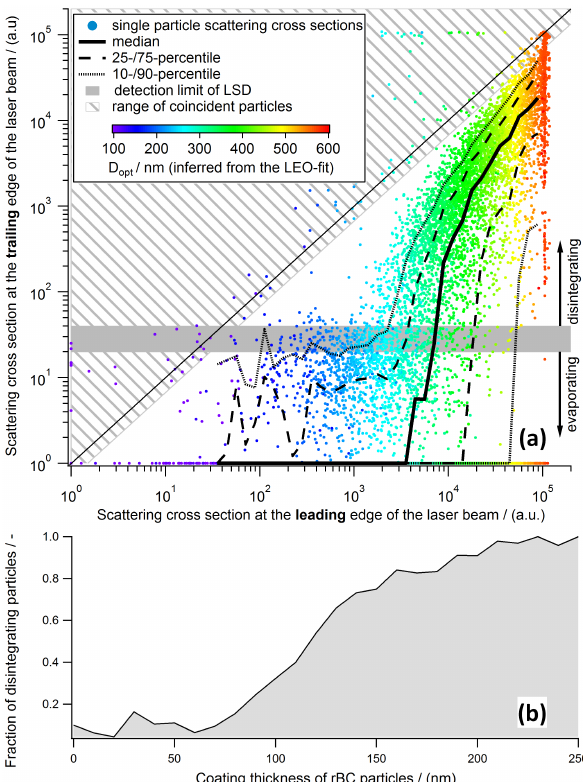
Figure 13. (a) Relation of the scattering cross-section at the leading edge and at the trailing edge of the laser beam for BC-containing particles (dots; color-coded for D opt determined by the LEO-fit approach) with median (solid black line), 25th/75th percentiles (dashed black lines) and 10th/90th percentiles (dotted black lines) shown for a sequence measured in the Pagami Creek fire plume (11:36–11:46UTC, 16 September 2011). The grey bar represents the detection limit of the LSD while the grey pattern indicates the range where the data points are attributable to coincidence of BC- free and BC-containing particles in the laser beam (black line: 1 : 1- line). Particles with scattering cross-section at the trailing edge of the laser beam remaining above the detection limit of the LSD in- dicate the disintegration of BC-containing particles. (b) Fraction of disintegrating particles to all rBC-containing particles as function of their coating thickness for the same sequence as in (a)